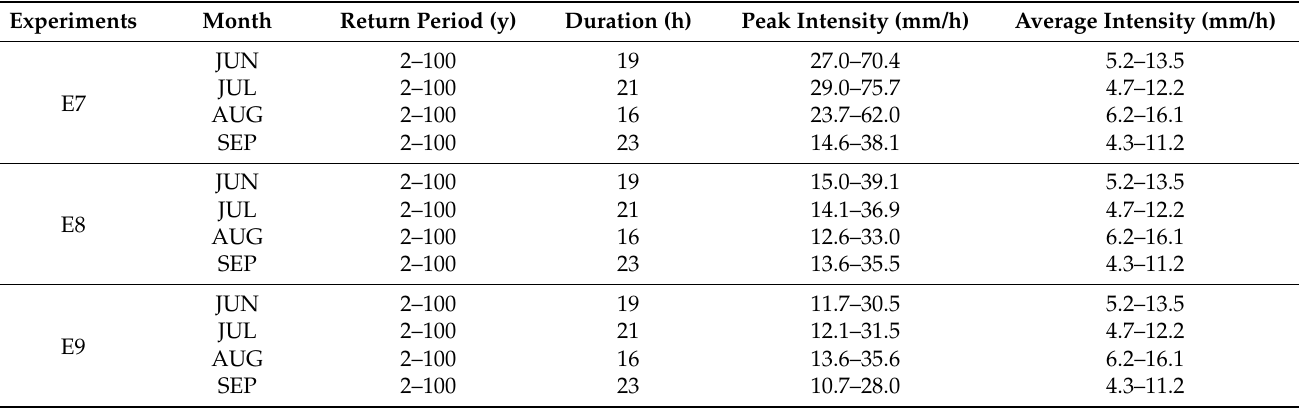
Table 10. Multi peak rainfall patterns